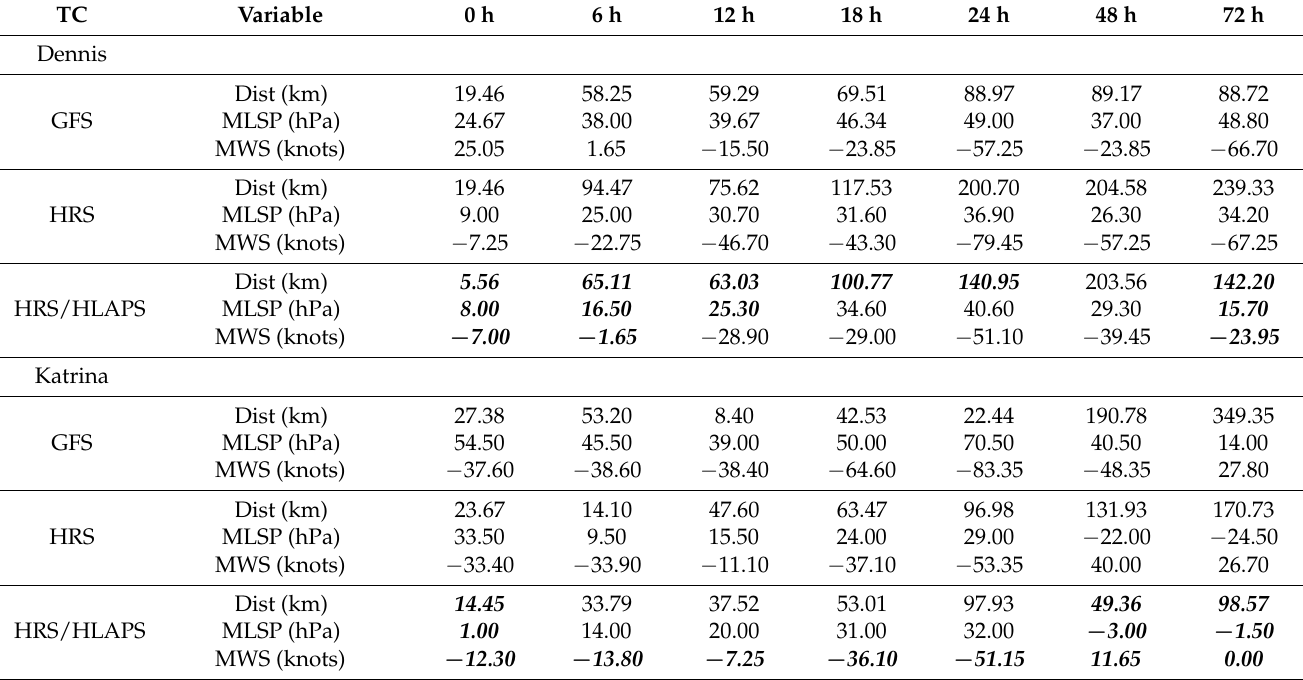
Table 2. Summary of the forecast track and intensity errors of the Global Forecasting System (GFS), Hurricane Research System (HRS), and HRS coupled with the Hurricane Local Analysis Prediction System (HRS/HLAPS) models for Hurricanes Dennis and Katrina relative to the best-analyzed observation (Best). Bold italics indicate the smallest